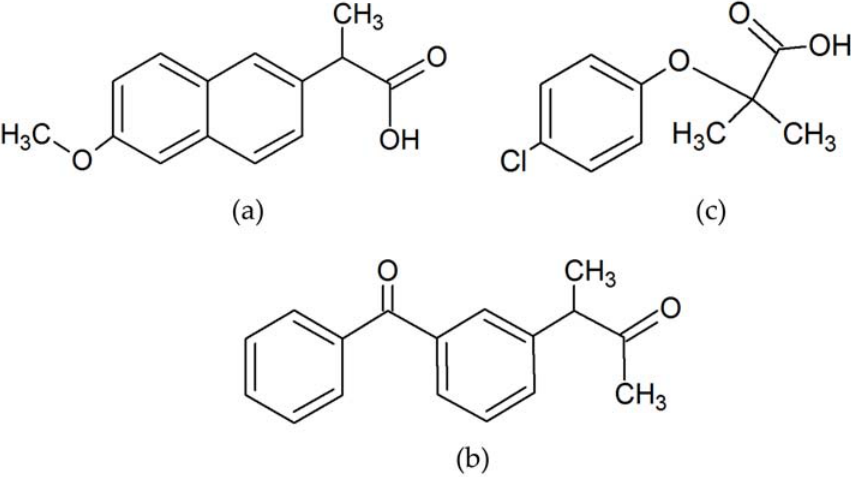
Figure 1. Molecular structure of: ( a ) naproxen; ( b ) ketoprofen; and ( c ) clofibric acid.